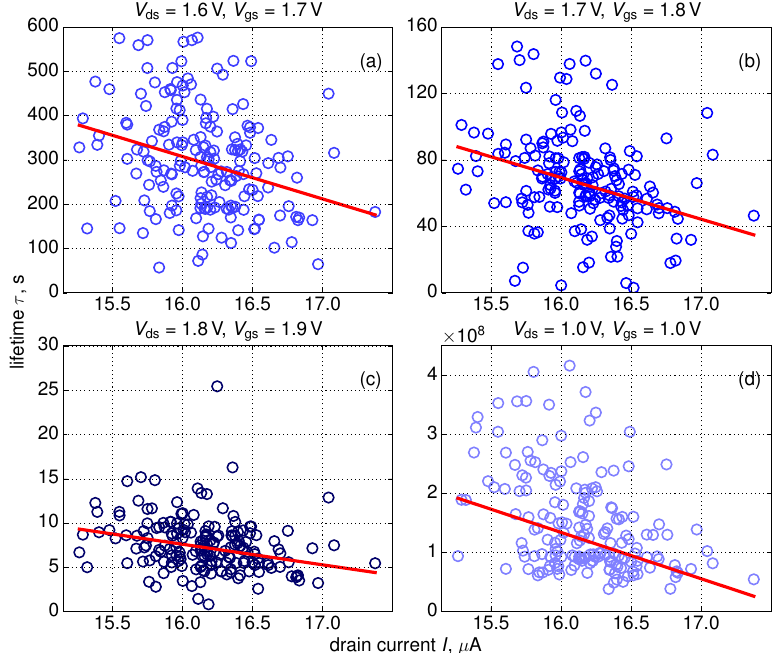
( 0 ) for all stress conditions. To evaluate d,lin